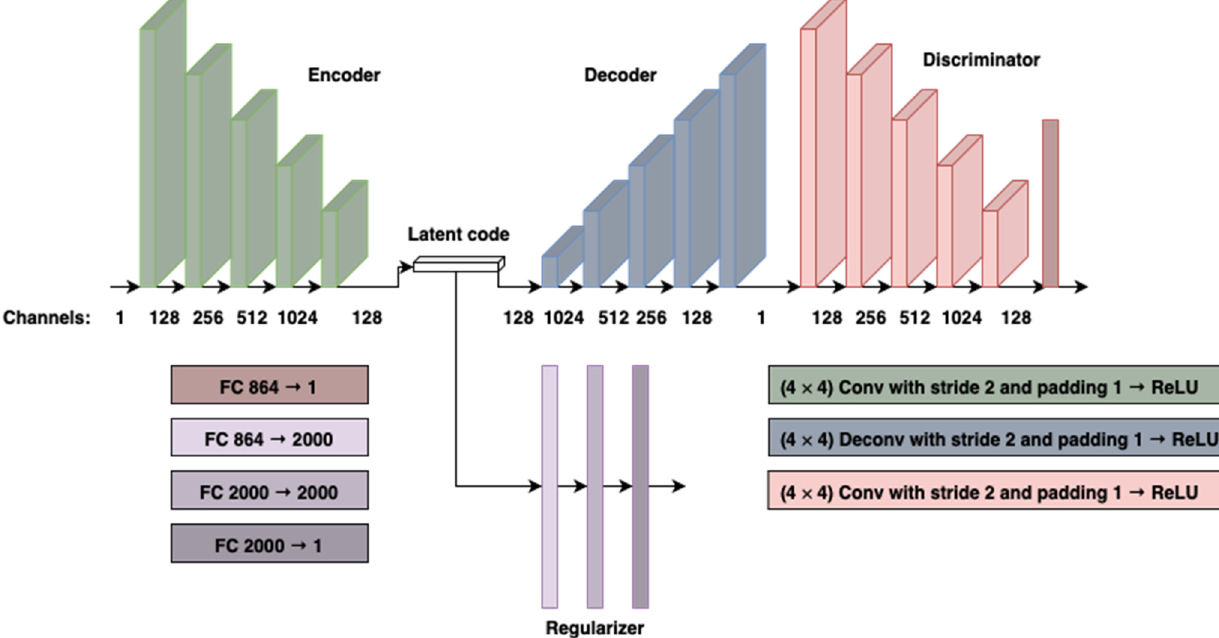
Figure 1. Model architecture of the IAE. Encoder and decoder are fully convolutional. The discriminator has both convolutional and fully connected layers. The regularizer is built of three fully connected layers. Abbreviations: FC—fully connected layer, Conv—convolutional layer, ReLU—rectified linear unit.